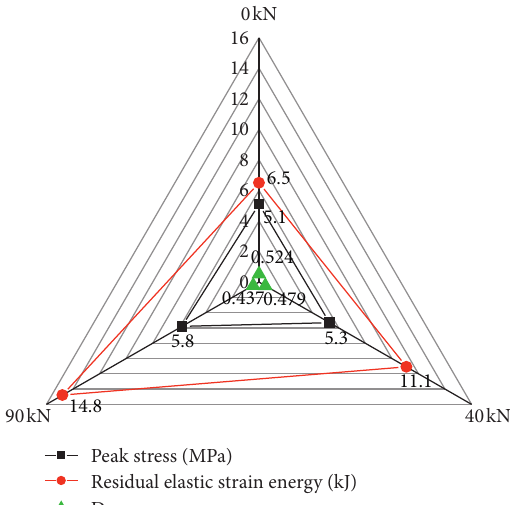
Figure 6: Comparison of peak strength, residual elastic strain energy, and damaging extent of anchorage body under different pretensions after the simulation was